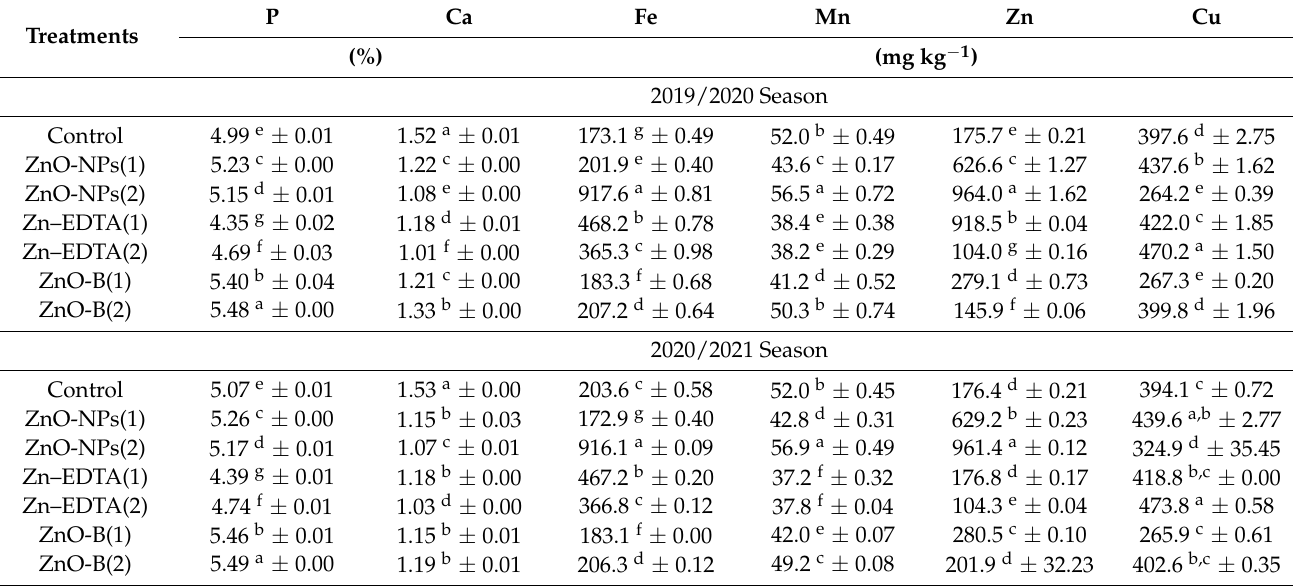
Table 5. Influence of foliar nourishment with some zinc (Zn) forms on leaf nutrient contents of carrot plants grown under Zn deficiency stress in two growth seasons.